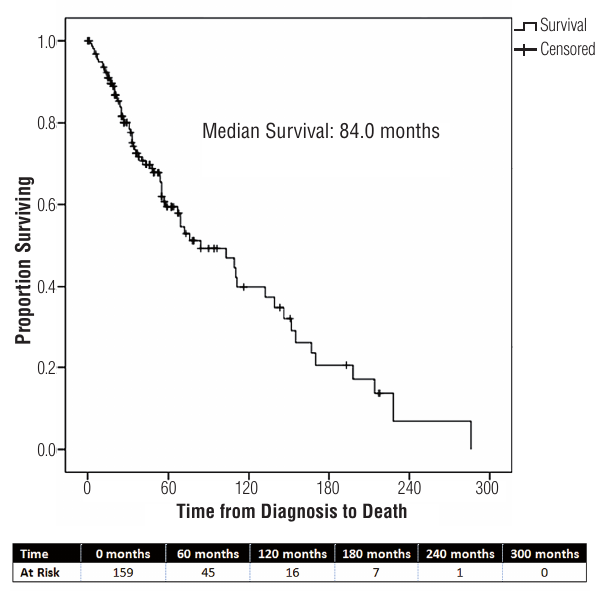
figure 1 - survival from time of